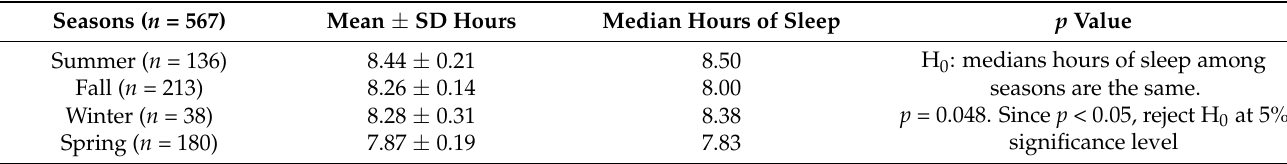
Table 2. Sleeping hours by seasons.